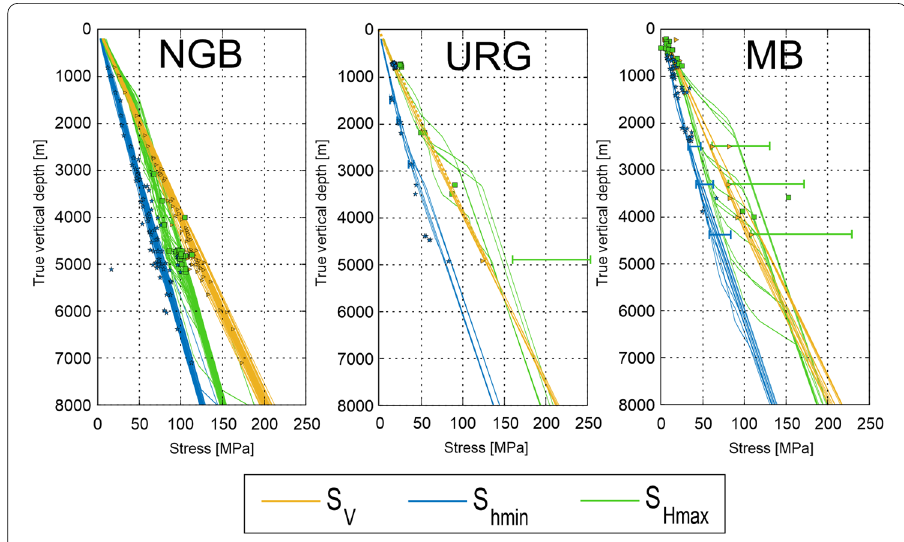
Fig. 12 Results from multiple virtual wells in the corresponding sedimentary basin of the model in comparison to measured and calculated magnitudes of S V , S hmin , and S Hmax . The uncertainties of the magnitudes if specified are displayed as error bars. North German Basin (NGB): Röckel and Lempp (2003), Fleckenstein et al. (2004), Stöckhert et al. (2013). Upper Rhine Graben (URG): Cornet and Burlet (1992), Klee and Rummel (1993), Valley and Evans (2007), Häring et al. (2008), Meixner et al. (2014), Azzola et al. (2019). Molasse Basin (MB): nagra (2001), Seithel et al. (2015), Backers et al. (2017), Budach et al. (2017), Drews et al. (2019), Garrard et al.